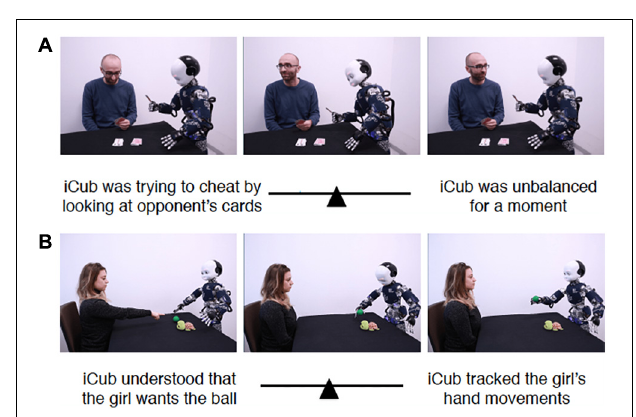
FIGURE 3 | Two scenarios with highest mentalistic scores. (A) Shows Item 25 which received the score 78.16 on average, while (B) depicts Item 24 which received the score of 68.83 on